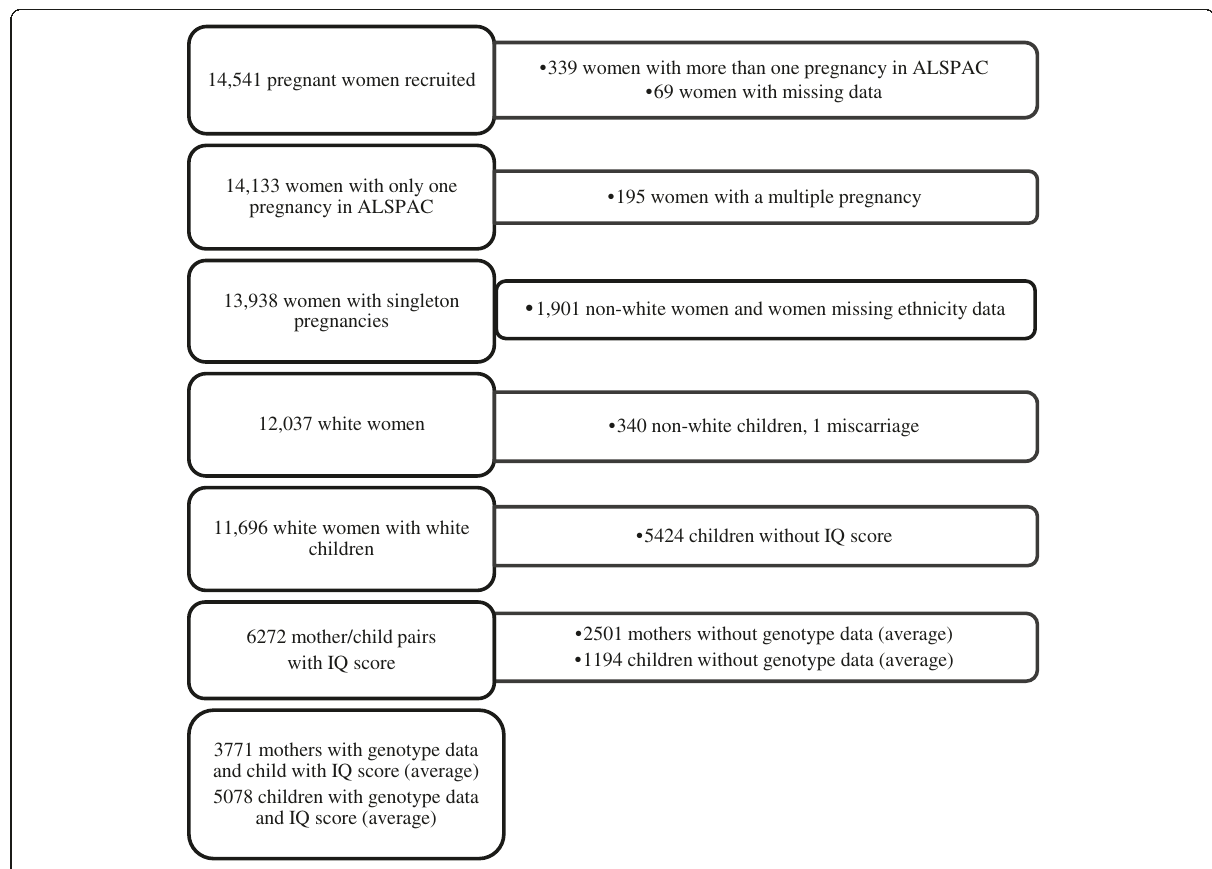
Figure 1 Flow-diagram of participants in the study and reasons for